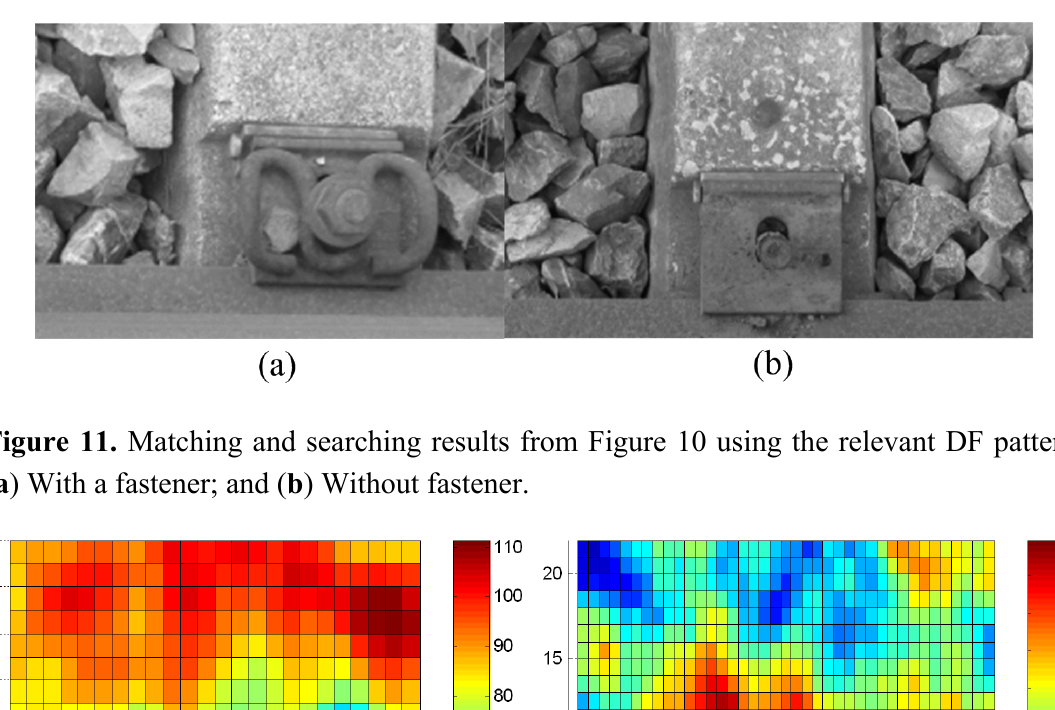
Figure 10. Image samples for fastener matching. ( a ) With a fastener; ( b ) Without a fastener.